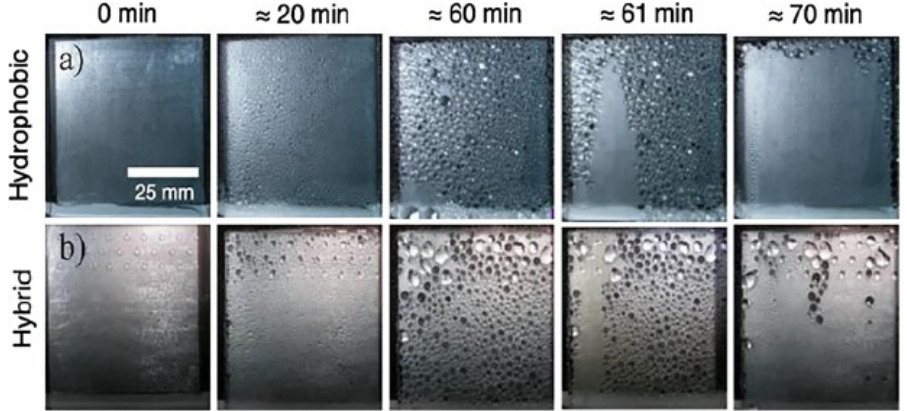
Figure 38. Condensation of water over time on ( a ) hydrophobic and ( b ) hybrid hydrophobic–hydrophilic surfaces [151].